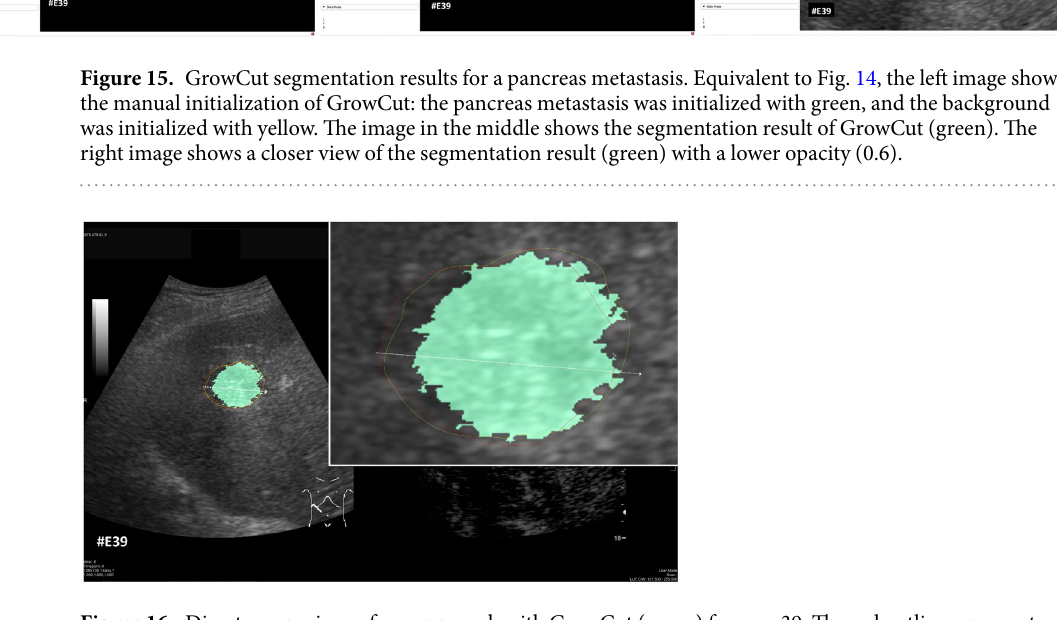
Firstly, we identified a parameter setting that achieved a high DSC for the first case in Table 2 (case 4). For an Approximate Volume of 40, an Intensity Homogeneity of 0.6, a Boundary Smoothness of 0.6 and a Max running time (min) of 10.0, we were able to achieve a metastasis segmentation result yielding a DSC of over ninety percent